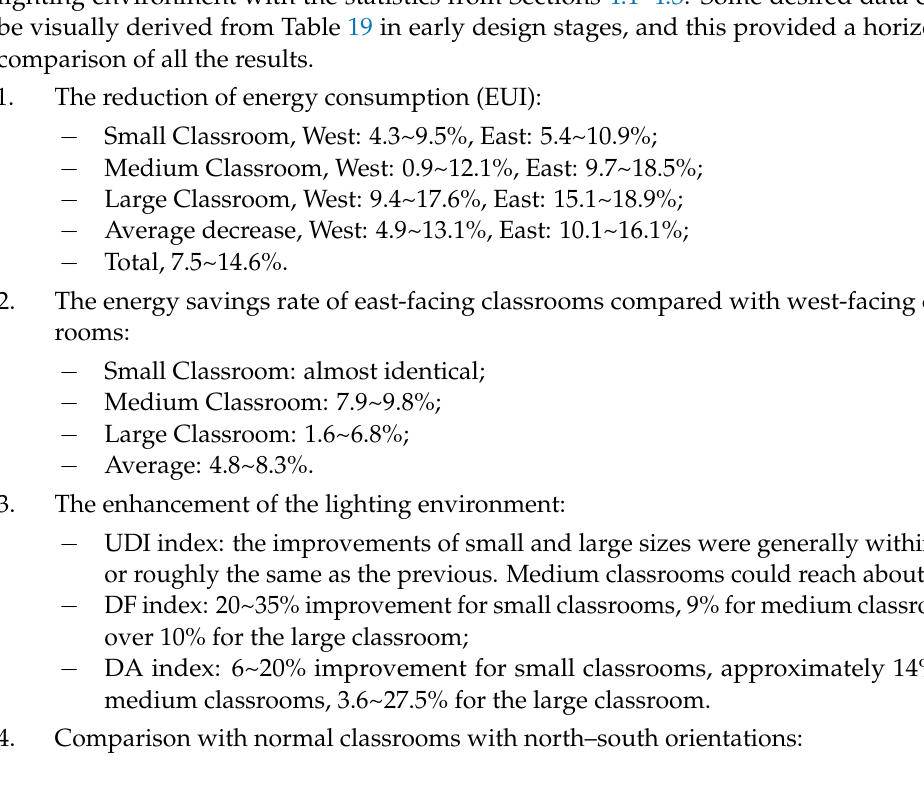
index in large-sized, east/south-oriented